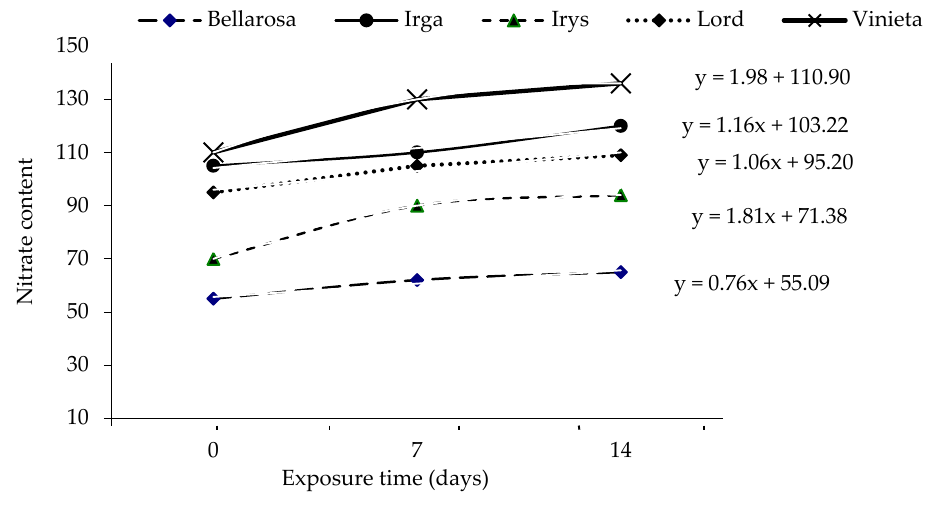
Figure 3. Equations of the relationship between the time of exposure to light and the content of nitrates in unwashed tubers of the studied varieties (mg·kg −1 FM).